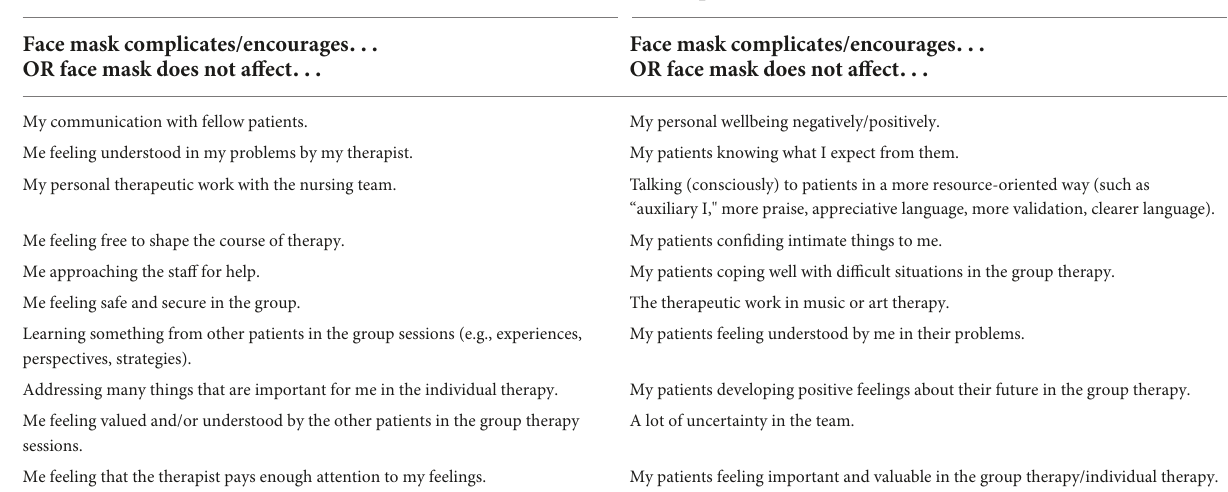
TABLE 1 Illustration of ten exemplary items for both groups. Patient side Face mask complicates/encourages . .. OR face mask does not affect .